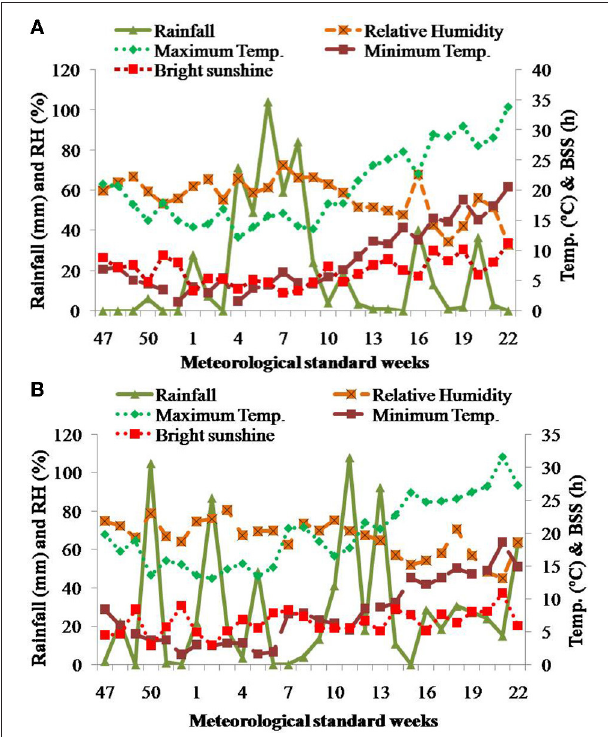
FIGURE 1 | Mean weather conditions during the crop growth seasons (A) 2018–2019 (Upper graph) and (B) 2019–2020 (Lower graph) at the experimental cultivation site in Palampur, HP, India. BSS, bright sunshine hour; RH, relative humidity.